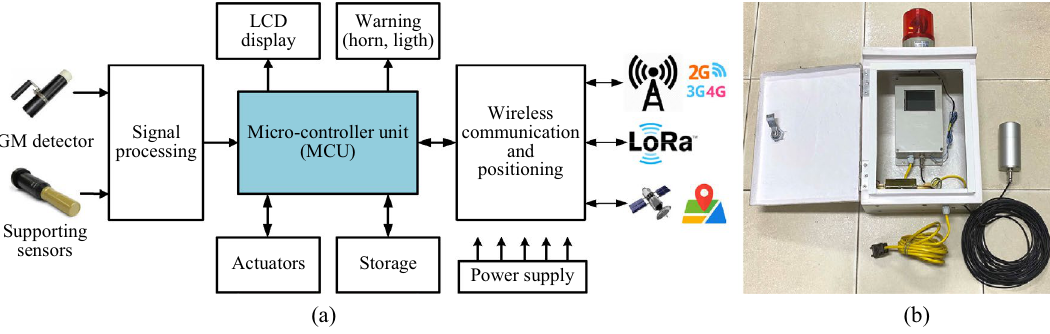
Figure 5. The fixed device: a architecture block diagrams and b an image of its prototype.